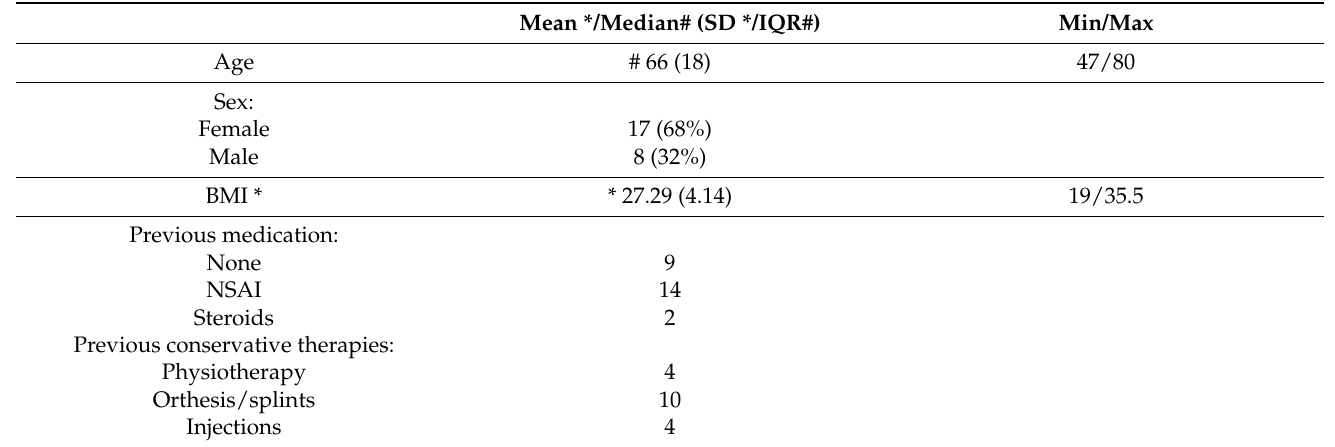
Table 1. Patient